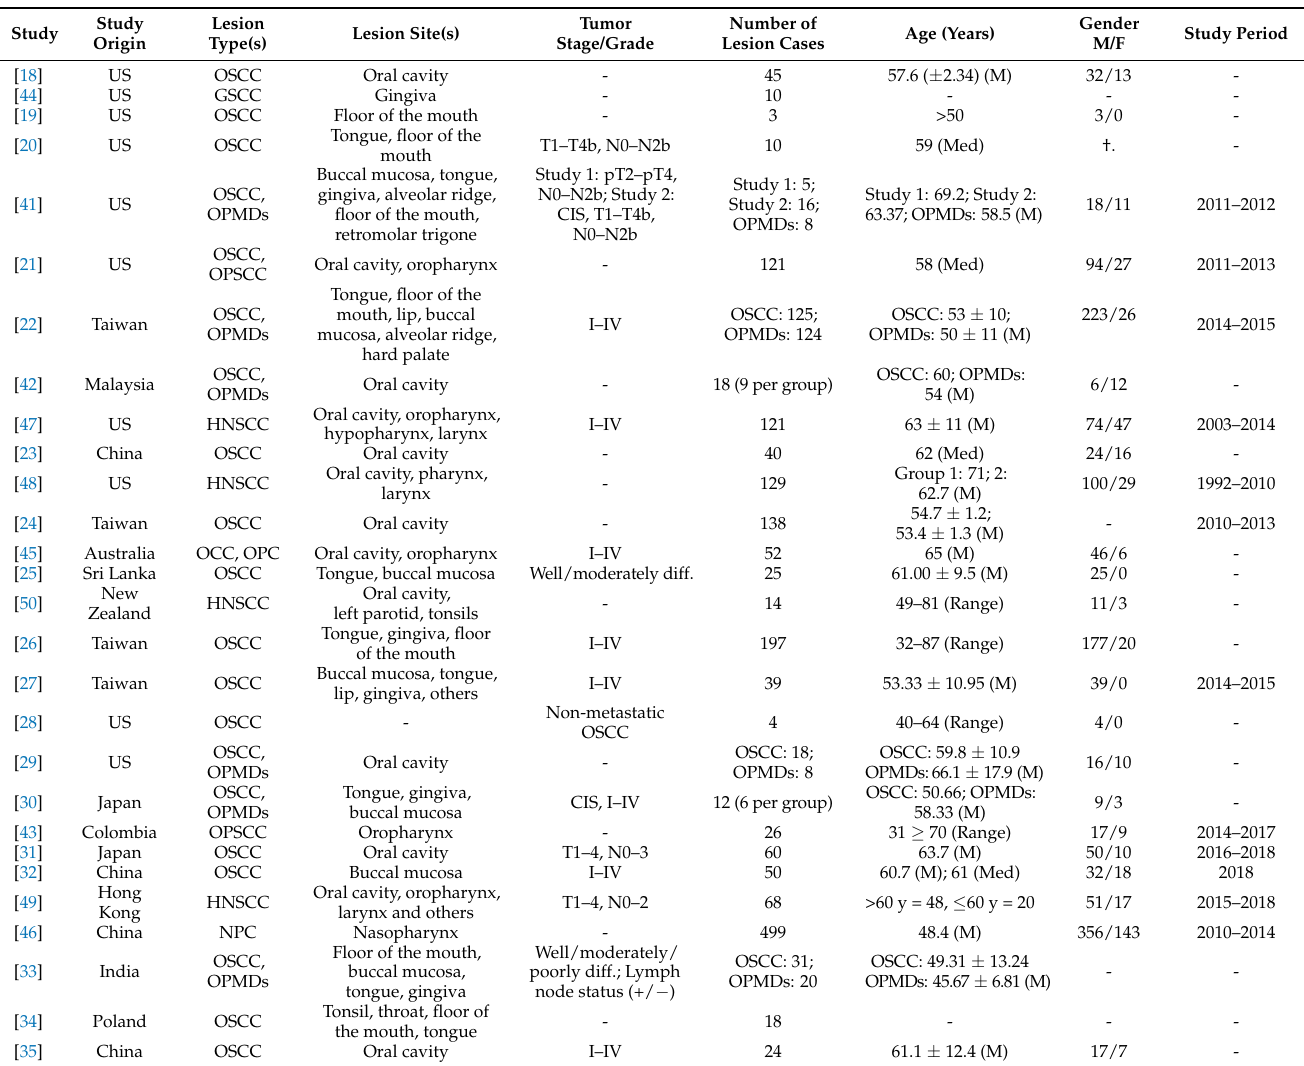
Table 1. The baseline characteristics of the included